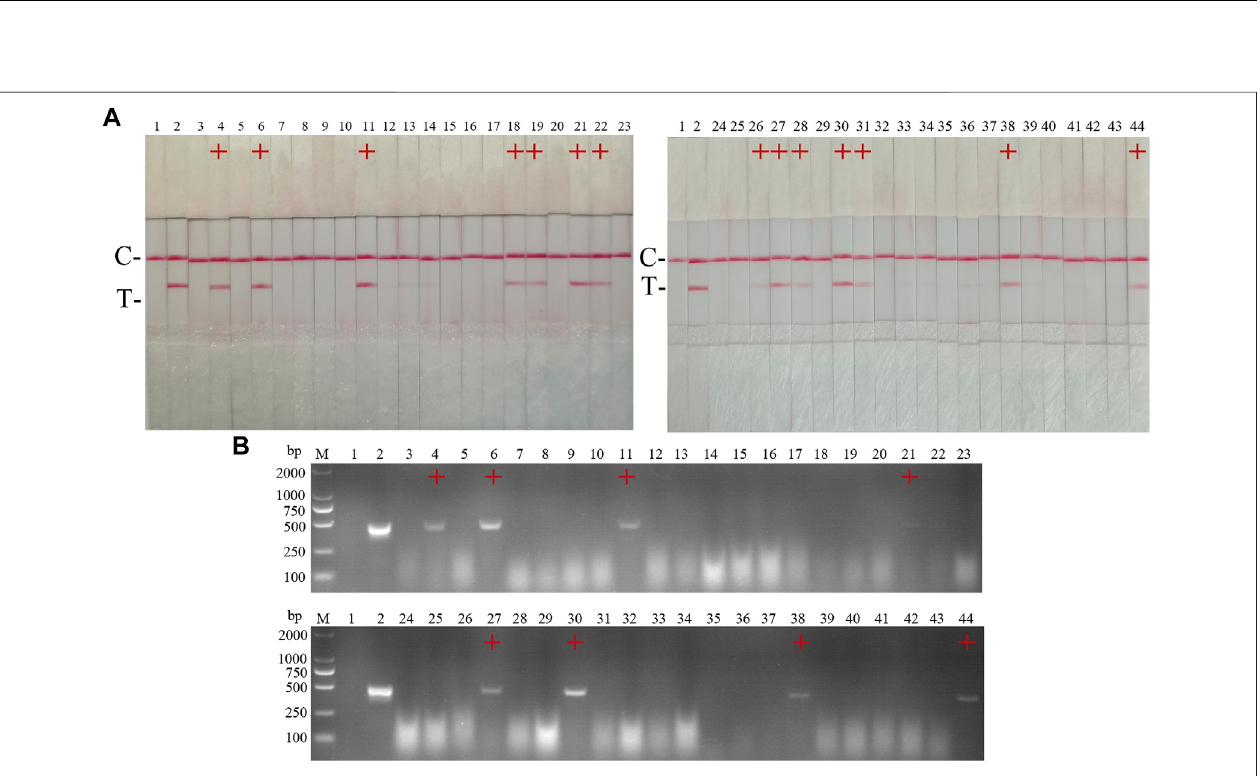
Frontiers in Molecular Biosciences |